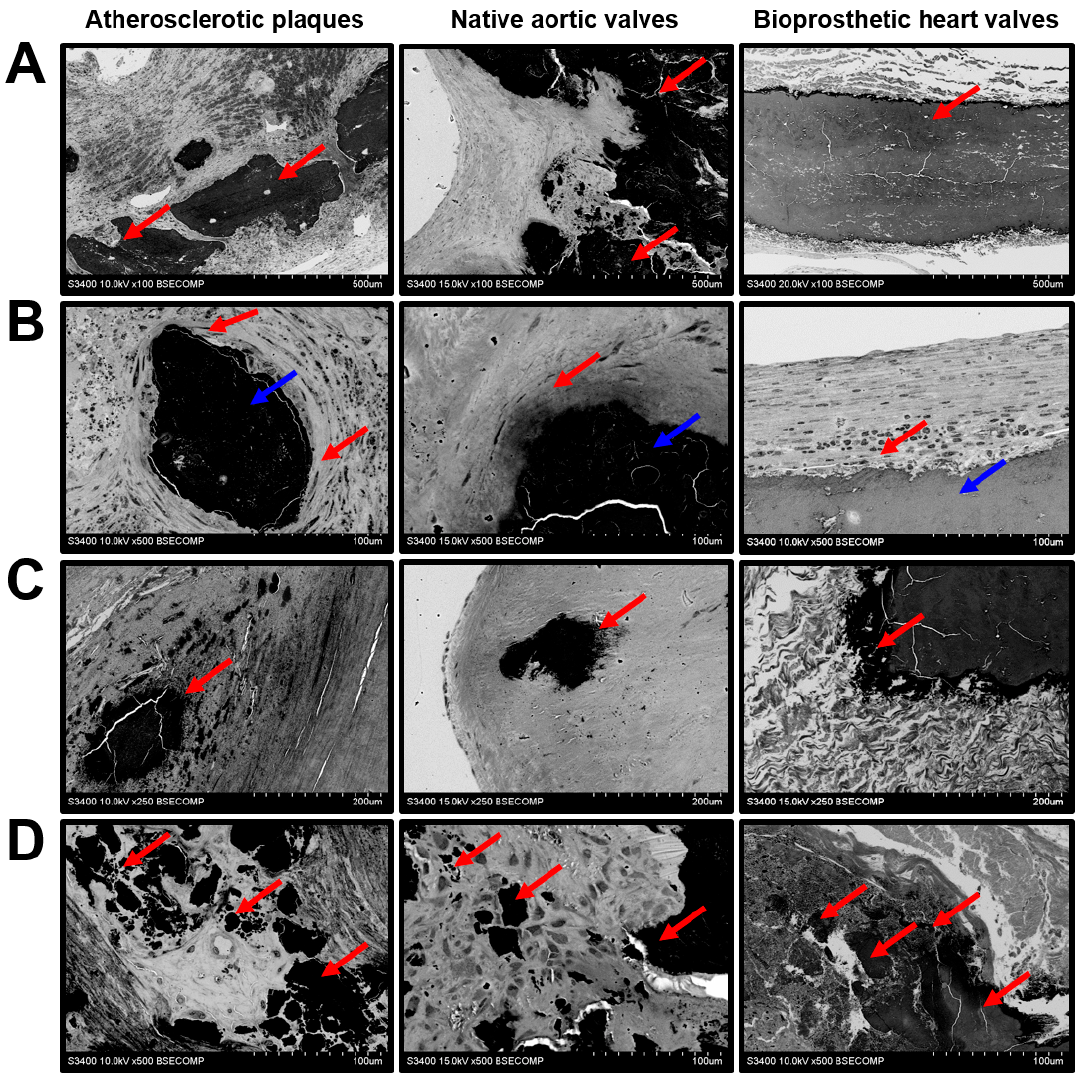
Figure 6. Mineralisation in the atherosclerotic plaques, calcified native AVs, and failed BHVs. ( A ) Macrocalcifications within the ECM (indicated by red arrows), magnification 100 × . ( B ) Encapsulated macrocalcifications (capsule indicated by red arrows, calcifications indicated by blue arrows), magnification 500 × . ( C ) Sharp-edged uneven calcifications (indicated by red arrows), magnification 250 × . ( D ) The diversity of calcification patterns (indicated by red arrows), magnification 500 × .